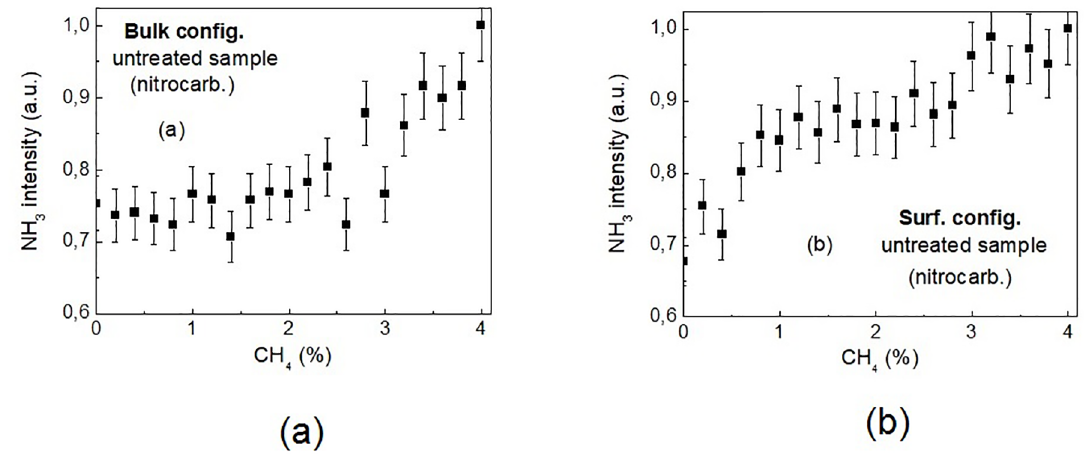
/H /CH mixture (a) 2 2 4